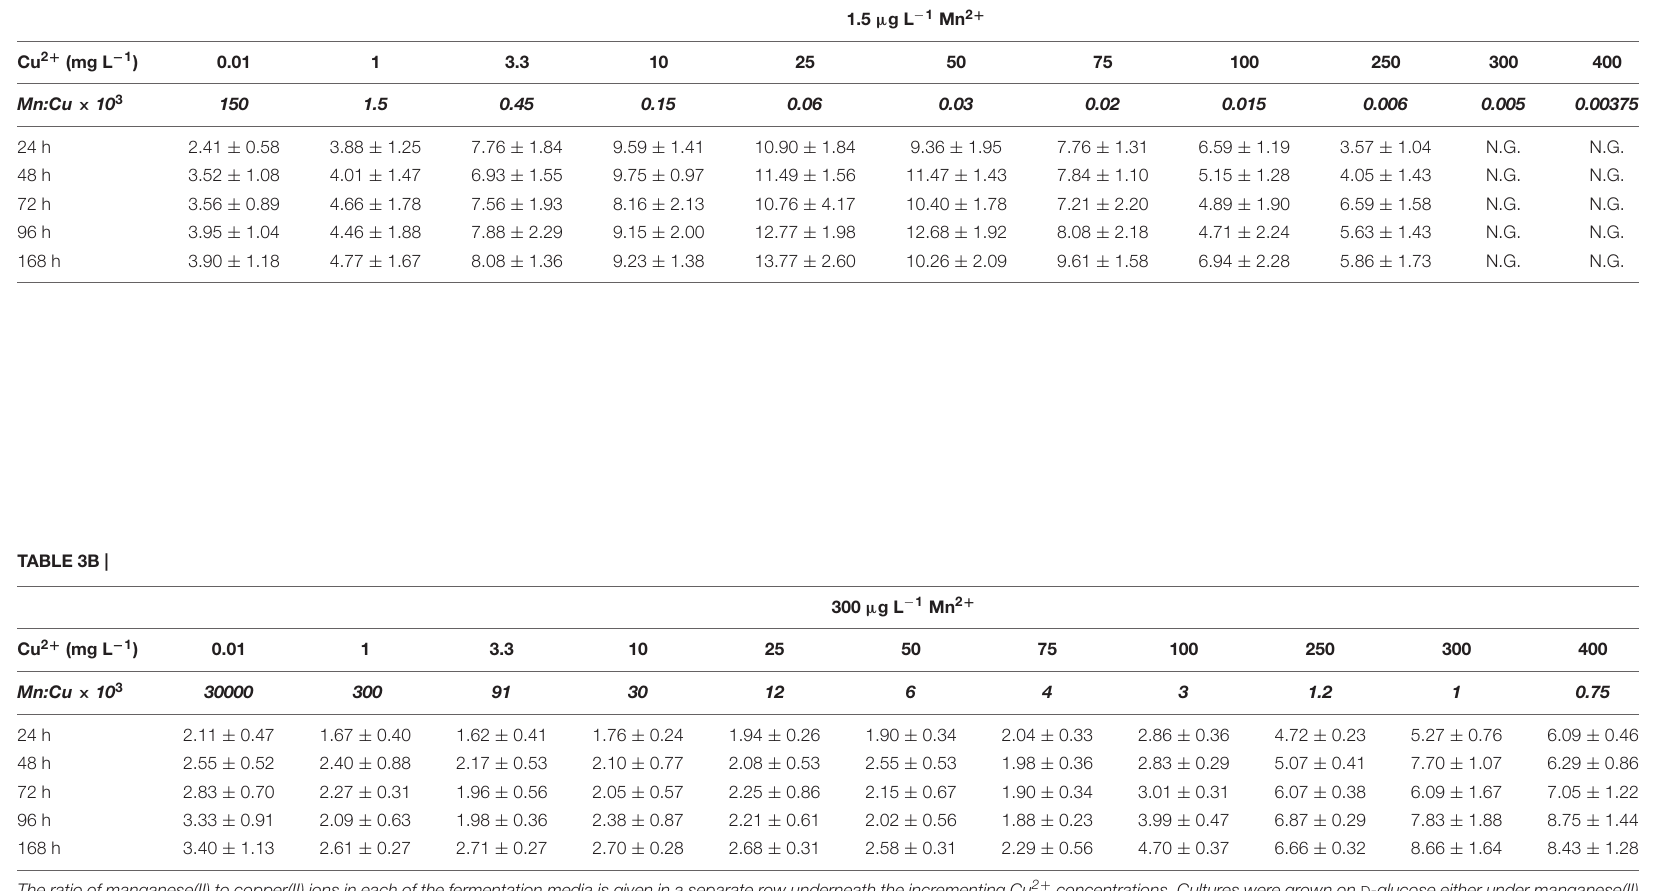
TABLE 3A | Average cell diameter in A. terreus NRRL1960 D -glucose-grown mycelia as a function of the copper(II) ion concentration in the culture broth at Mn(II) limitation and